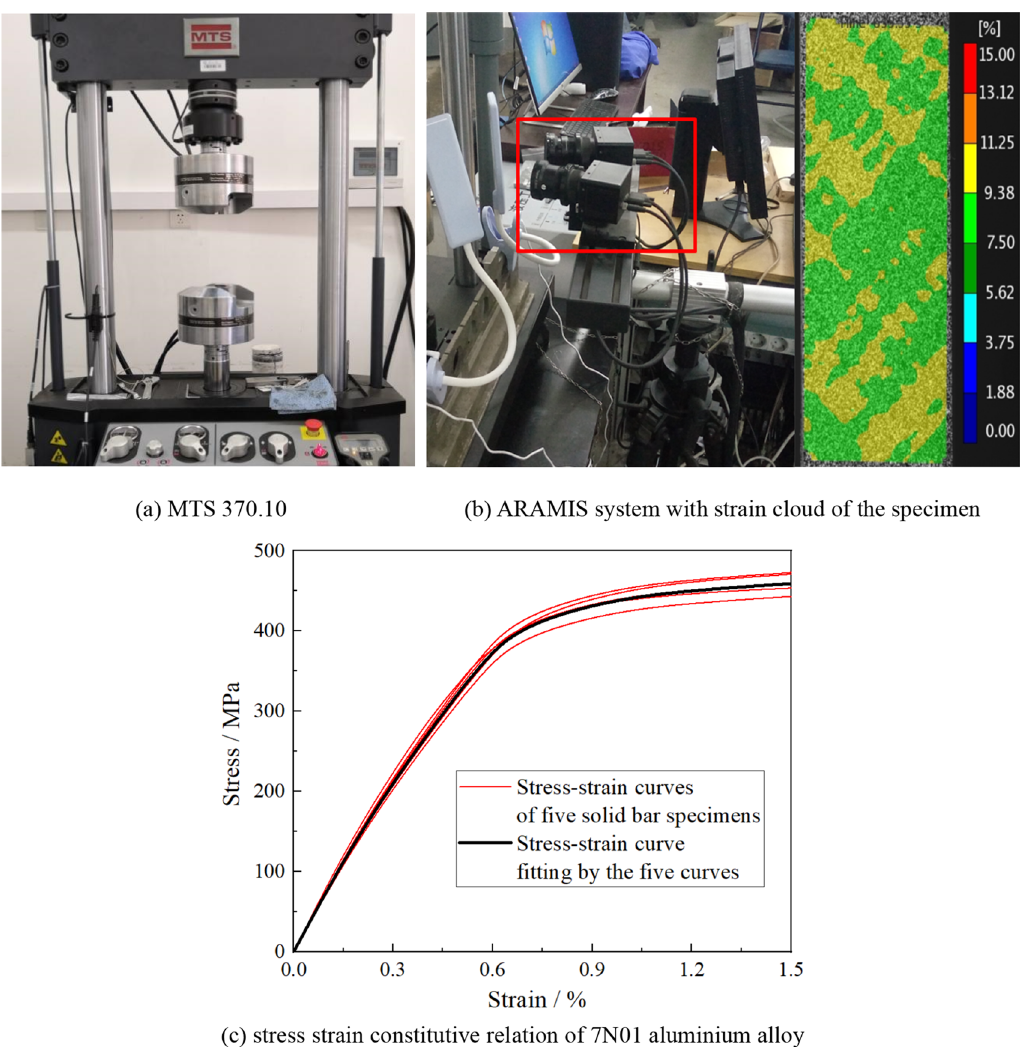
Figure 5. Experimental equipment ( a , b ) for uniaxial tensile experiment and the tested stress–strain curve of 7N01 aluminium alloy ( c ).